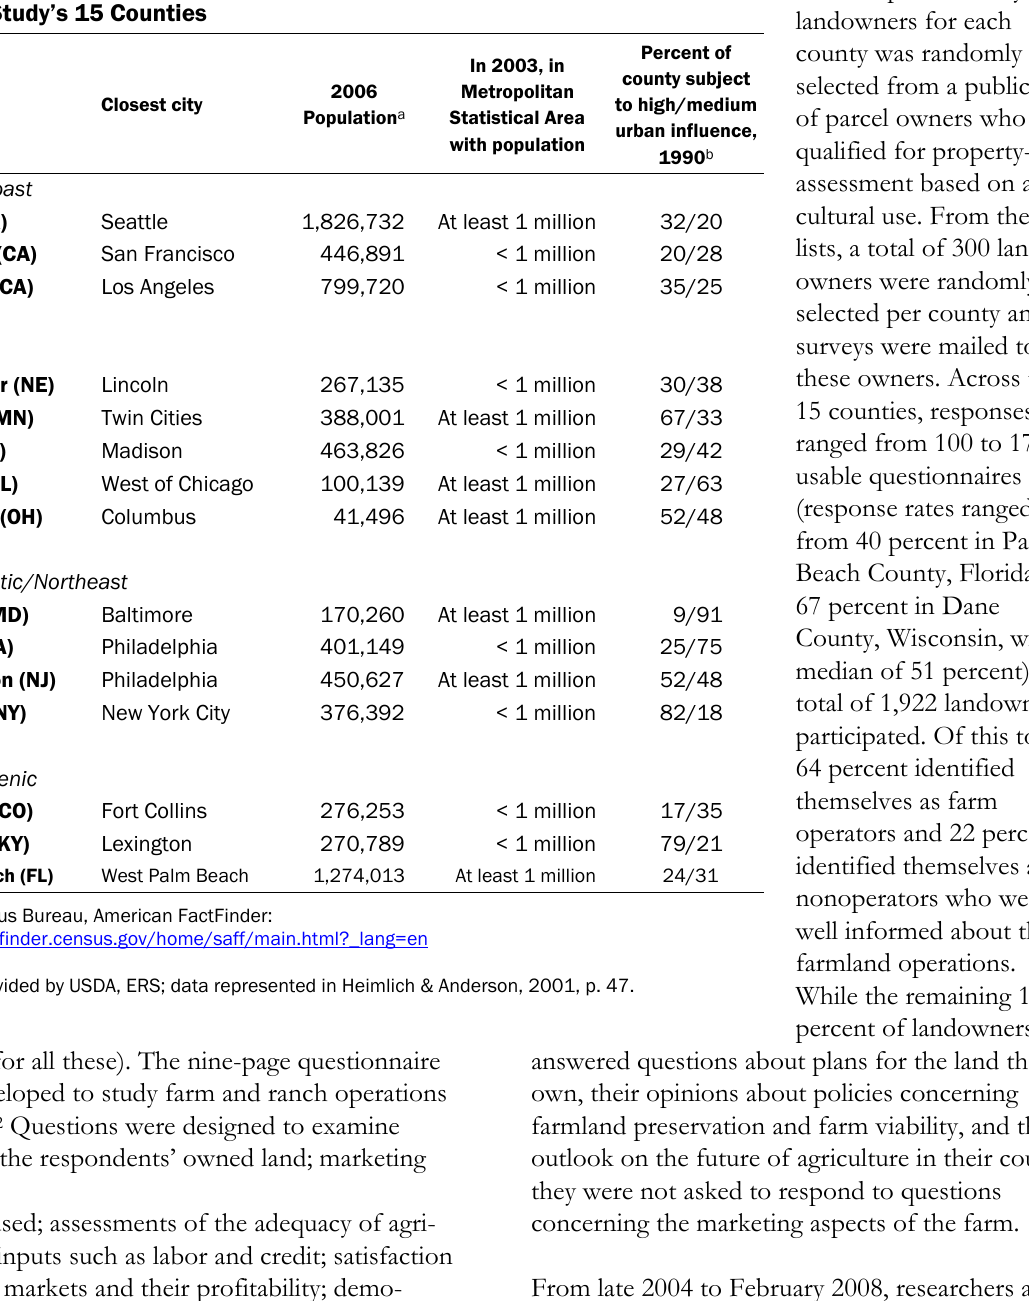
Table 1. Population and Urban Influence Indicators for the Study’s 15